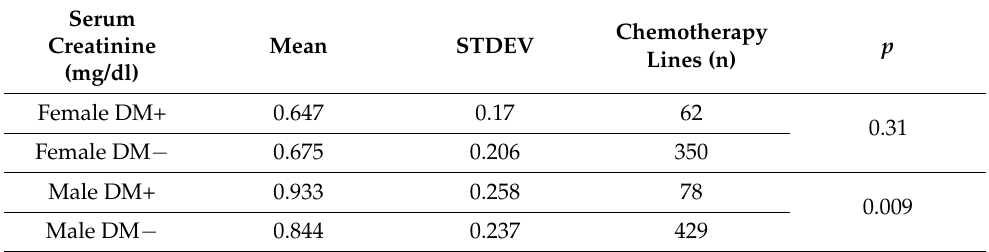
Table 6. Average TTF by sex, DM status, and haemoglobin value.